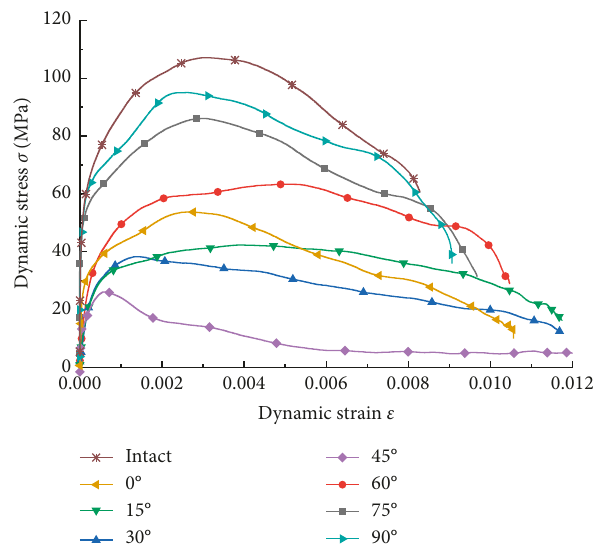
Figure 9: Representative dynamic stress-strain curves of specimens with different fissure